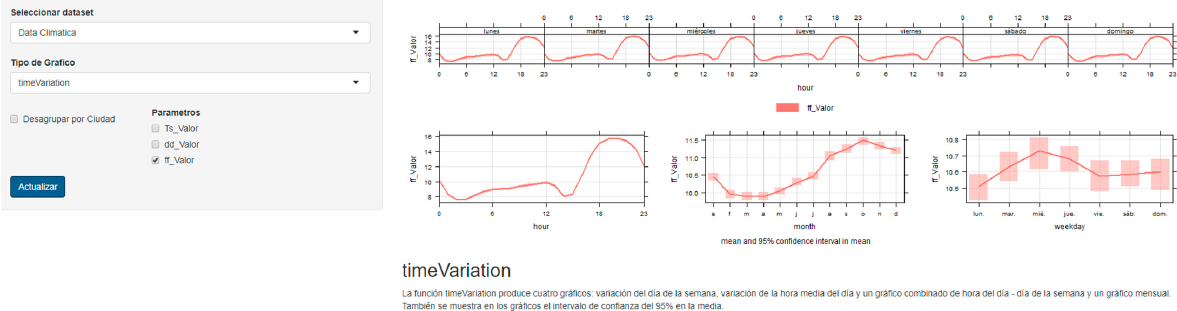
Figure A9. Temperature times series for combined meteorological stations between 2015 and 2020 were generated with the timeVariation option.